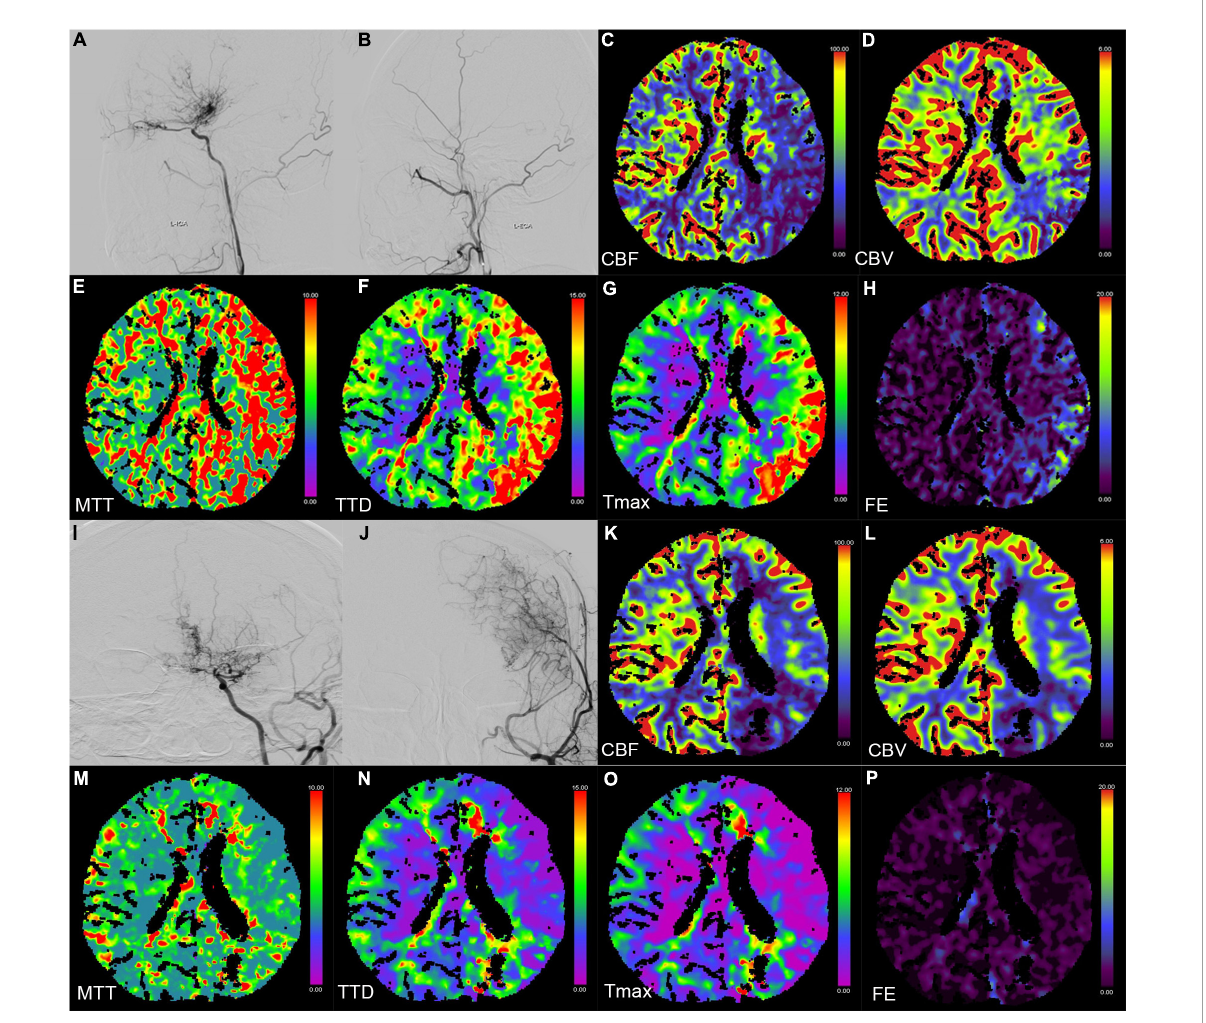
FIGURE2 Digital subtraction angiography (DSA) and CT perfusion (CTP) images of a 23-year-old female patient with a history of headache for 2 months ( A–H preoperation, I–P postoperation). (A,B,I,J) The DSA images show a patient bypass with supply to the majority of the middle cerebral artery territory after direct bypass surgery. (C–H,K–P) The CTP images show that the hemodynamics improved after revascularization in the left